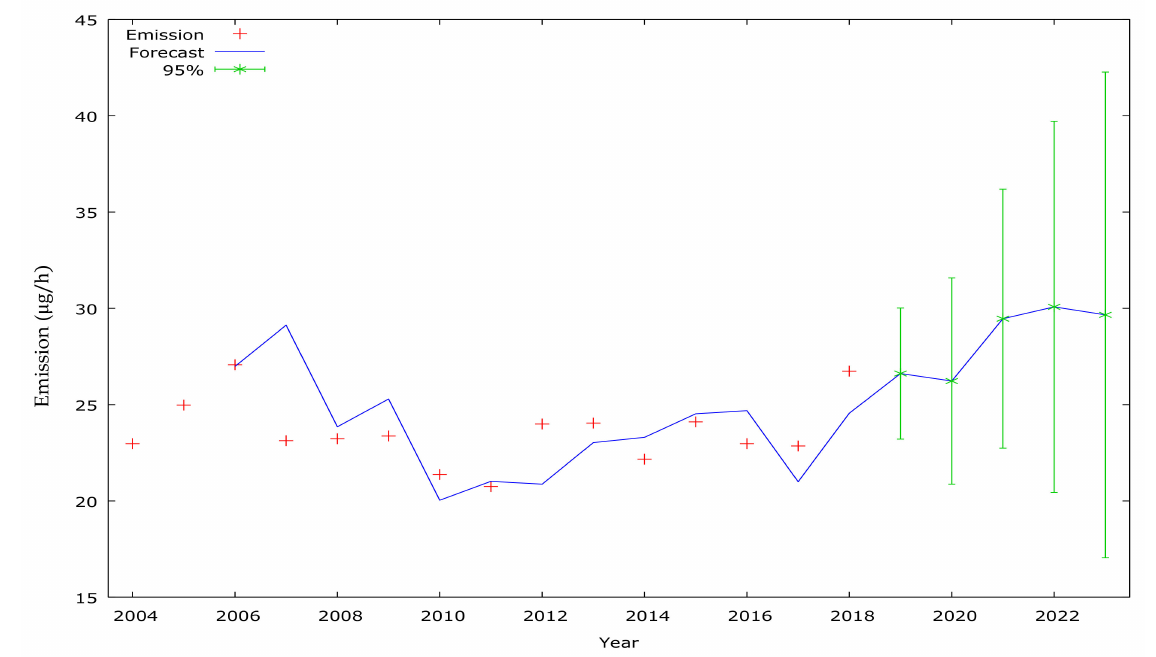
Figure 3. Graph of the dependence of the average NO 2 emission µ g/h on the values predicted using the ARIMA model (2,2,0) (averaging time 1 h), zone code PL140. Source: own elaboration, based on data from Chief Inspectorate of Environmental Protection [37]. Table 2. Indicators of the created prognostic models concerning the emissions of NO 2 , CO, SO 2 , and PM 2.5 in Poland. Indicator SO 2 CO NO 2 PM 2.5 MAPE, % 14.34 RMSE,